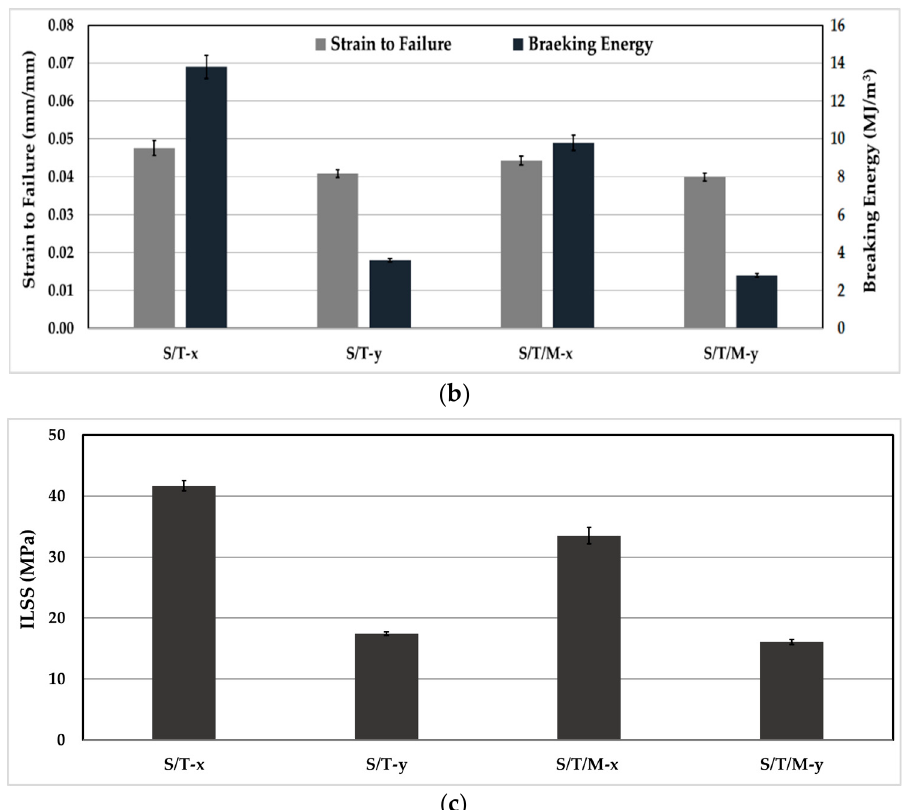
Figure 13. Effect of the presence of 10% moisture in the silk fabric on the mechanical performance of silk/epoxy laminates: ( a ) Flexural strength and modulus; ( b ) strain to failure and breaking energy; and ( c ) ILSS.